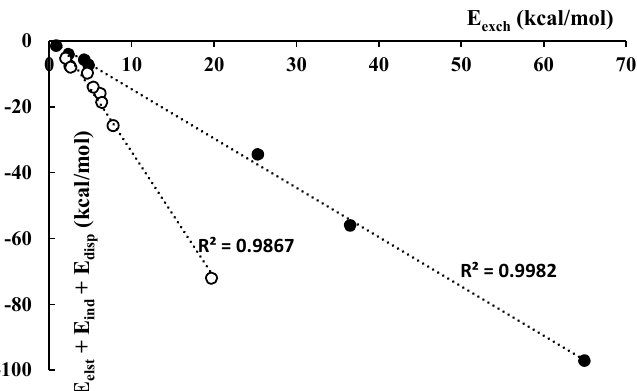
Figure 2. The relationships between the exchange energy term and the sum of attractive energy terms (both in kcal/mol); black circles correspond to the proton-bound complexes and white circles to the lithium cation-bound ones; for both sub-samples the linear correlations are presented.